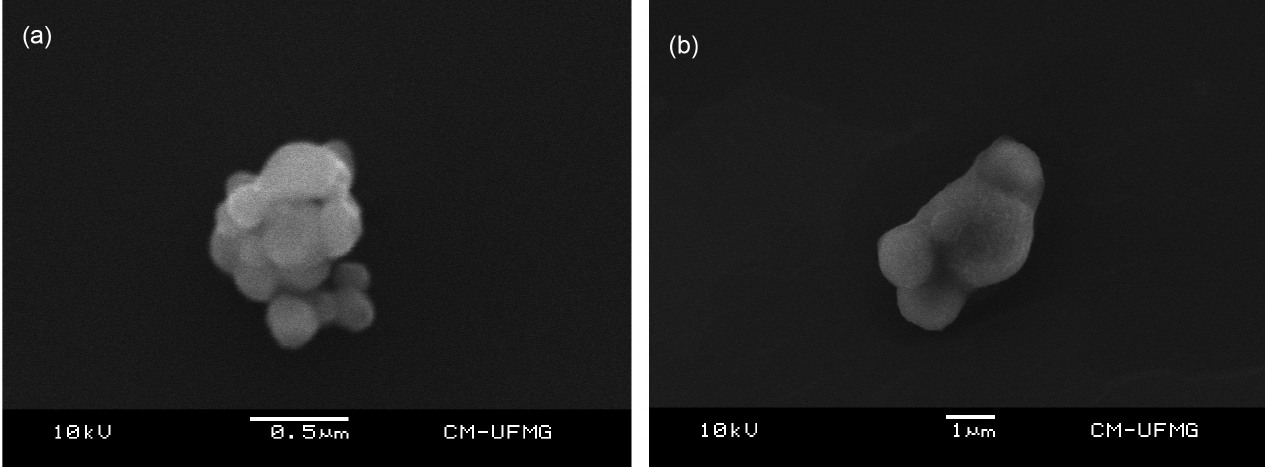
FIGURE 2 - Electron micrographs of the PLGA/curcumin-loaded nanoparticles at 10,000 (a) and 100,000 (b)